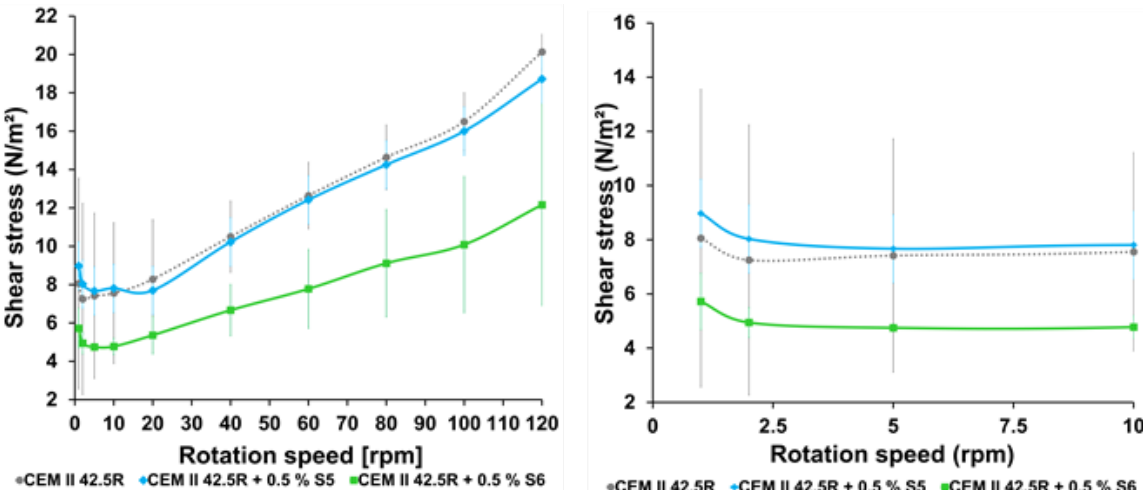
Figure 3. Investigation of the shear stress in dependence on rotation speed (( left ) full graph, ( right ) enlargement)) of the cement CEM II 42.5R at w/c = 0.5 with 0.5% of additives. Test conditions: 0.5% bwoc of SPs; w/c = 0.5; CEM II 42.5R = 30 g (EN197-1); deionized H 2 O = 15 g.